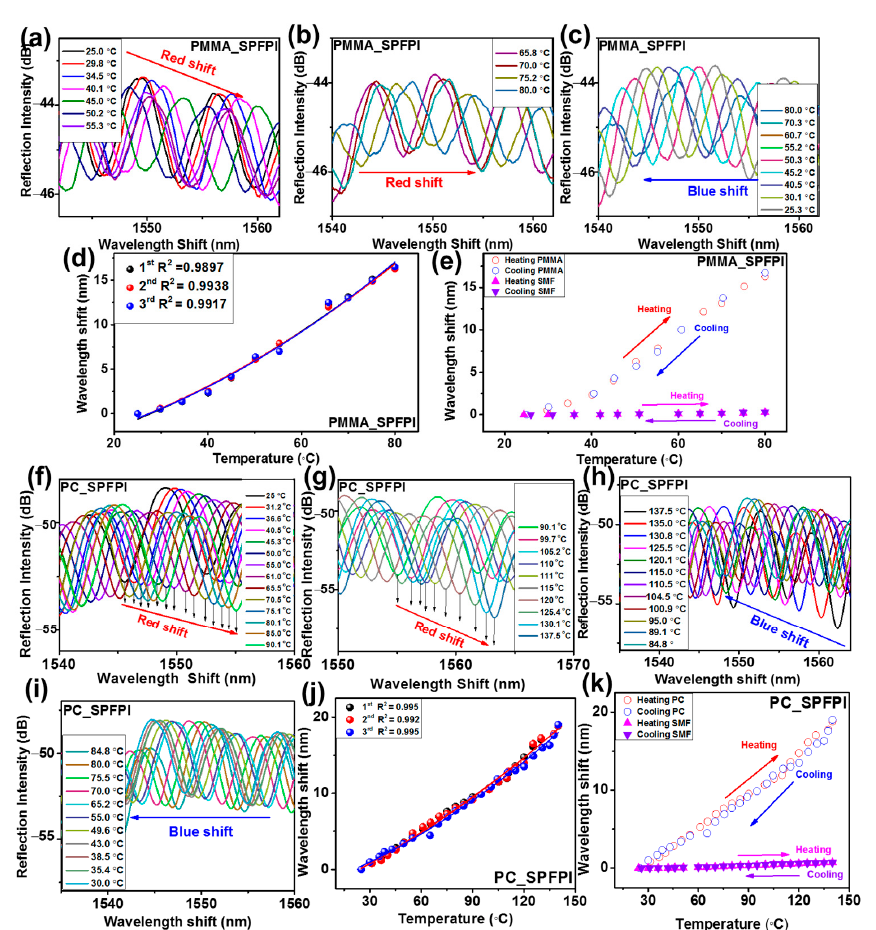
Figure 6. Reflected spectra with increase in temperature ( a , b ), with decrease in temperature ( c ) for PMMA_SPFPI, ( f–i ) for PC_SPFPI with increase and decrease in temperature, wavelength shift for three measurements for PMMA_SPFPI ( d ), PC_SPFPI ( j ), average wavelength shift associated with SMF ( e ) for PMMA_SPFPI, and ( k ) for PC_SPFPI sensors.